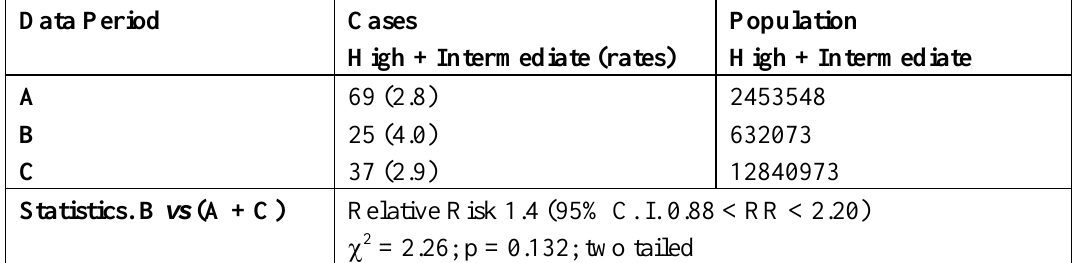
Table 4. Statistics of infant leukemia rates in the UK based upon high + intermediate exposure groups in Scotland, North Wales and Yorkshire. Comparison of exposed (B) and unexposed (A + C) periods after Petridou et al. ; data from